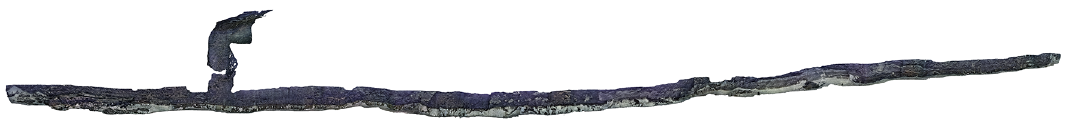
Figure 13. Textured 3D model of AUTT28